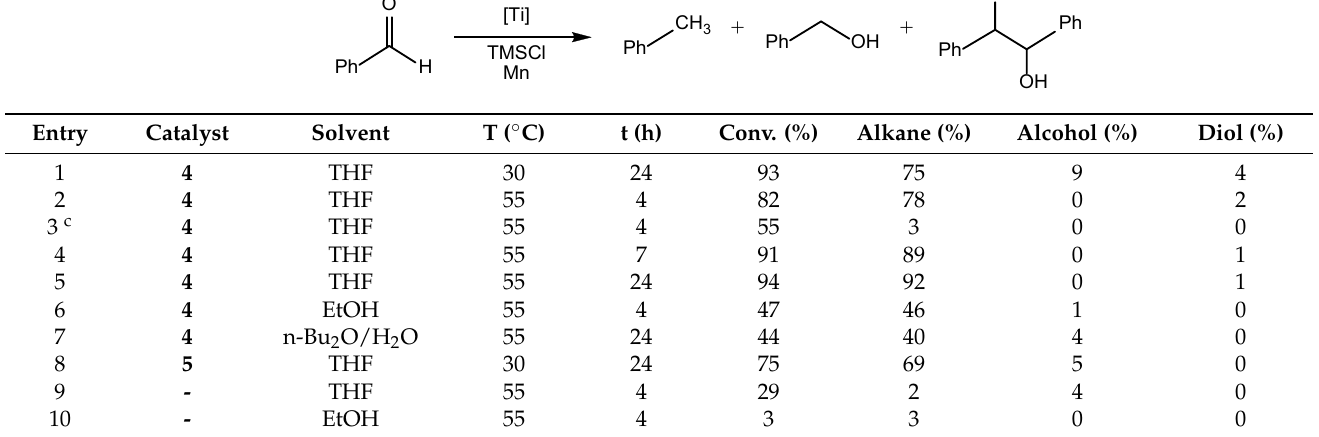
Table 1. Catalytic data for the reduction of benzaldehyde a,b .